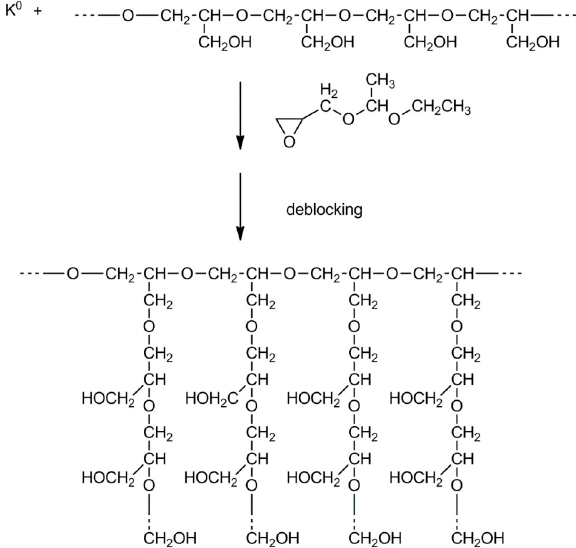
Scheme 15. Synthesis of comb-like polyglycidol.